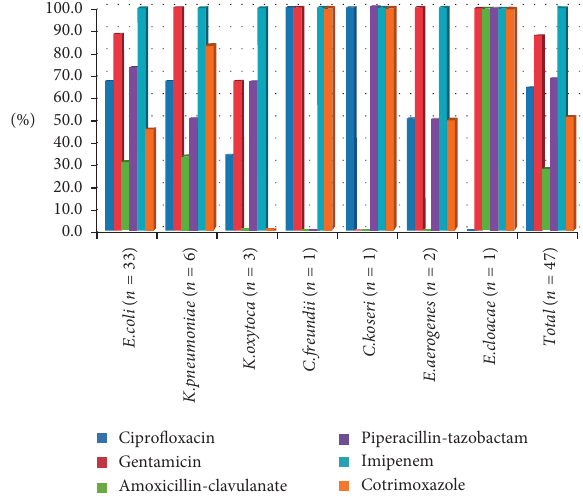
Figure 1: Antimicrobial susceptibility of ESBL-producing strains ( n � 47) in OPD participants.